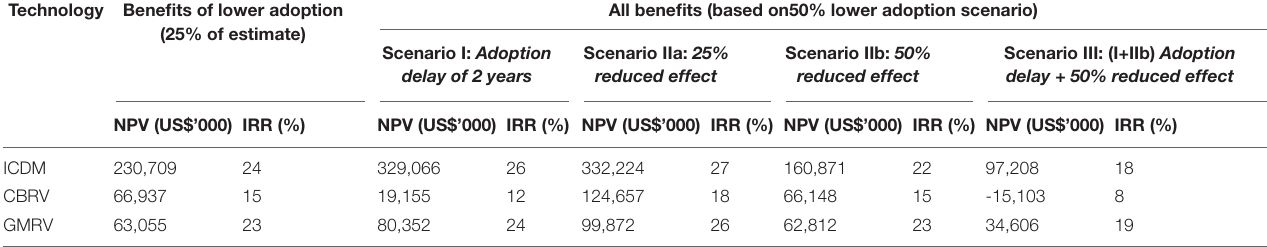
TABLE 7 | Sensitivity analysis—benefits under different adoption scenarios. Technology Benefits of lower adoption All benefits (based on50% lower adoption scenario) (25% of estimate) Scenario I: Adoption delay of 2